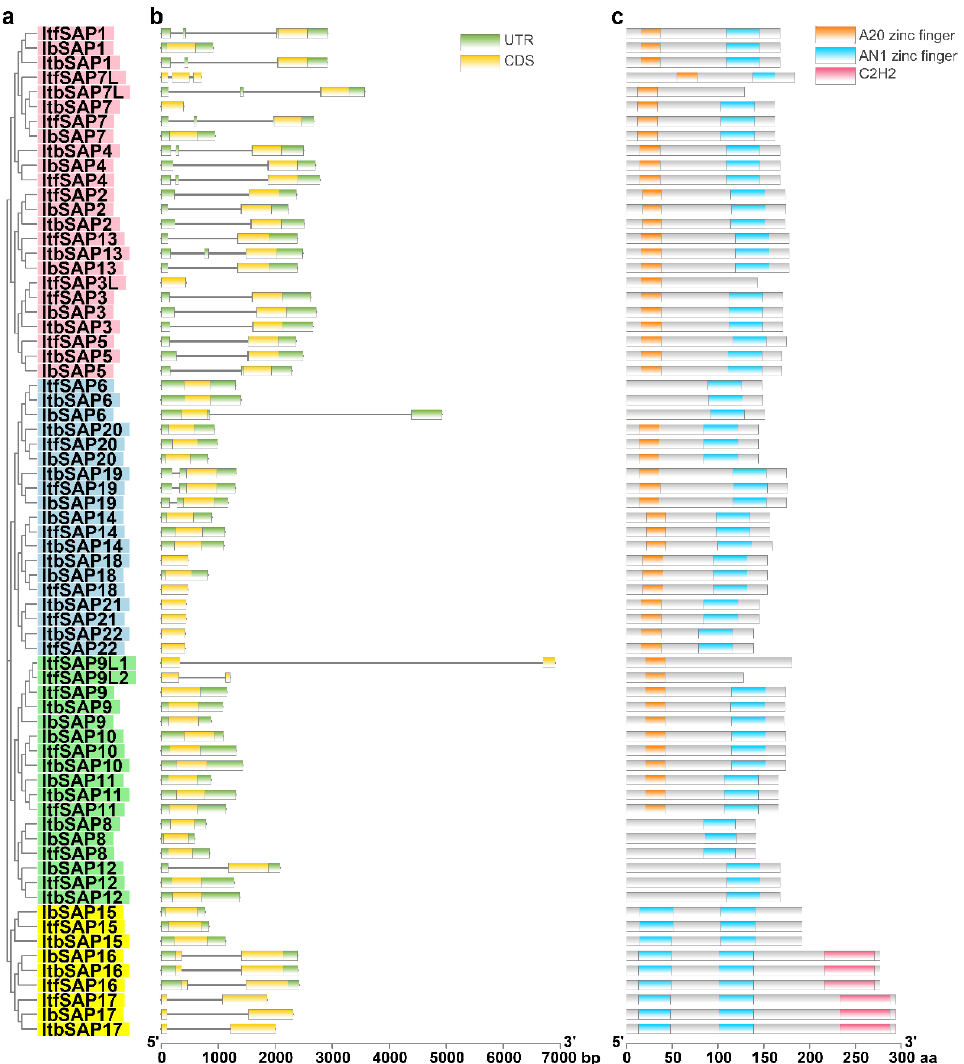
Figure 3. Gene structure and conserved domain analysis of IbSAPs, ItbSAPs, and ItfSAPs. The phylogenetic tree ( a ) was built by MEGA-X via the neighbor-joining method for 1000 bootstrap replicates using the full-length amino acid sequence alignment by the MUSCLE algorithm. Gene structures ( b ) obtained from the annotation of I. batatas , I. triloba , and I. trifida genome and conserved domains ( c ) analyzed by CD-search were visualized using tbTools.